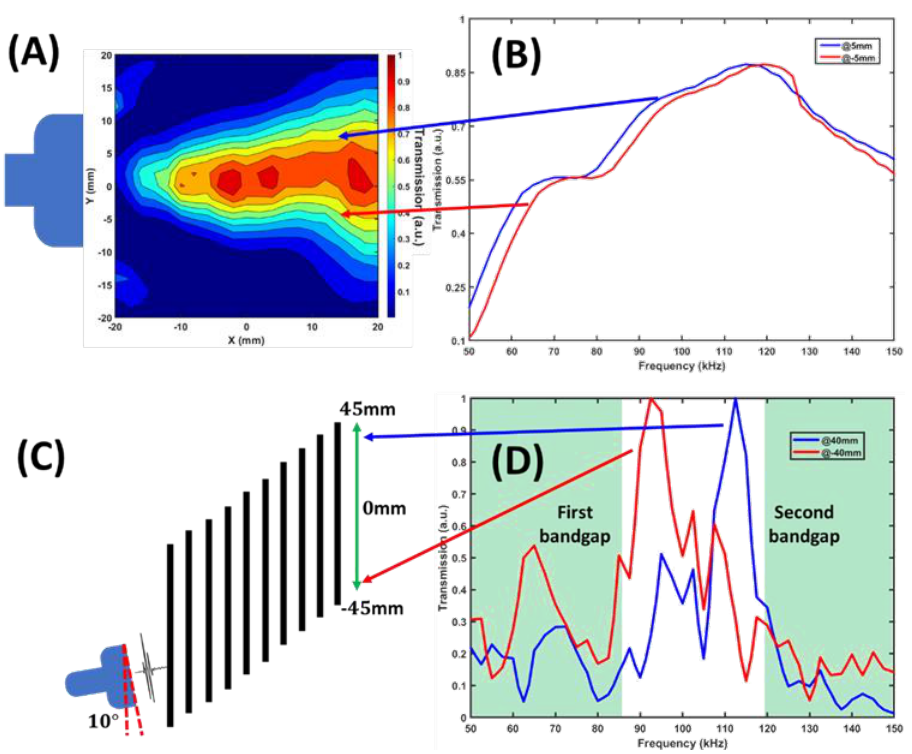
Figure 4. Experimental results of pulse decomposition measured at two symmetrical vertical points. ( A ) and ( B ) show the symmetric pressure map and almost equal transmission spectra obtained in free water without superlattice. ( C ) and ( D ) show different spectral compositions of the signals measured 40 mm above and below superlattice axis. The two spectra were measured at the distance 6 mm behind the last layer of the superlattice.